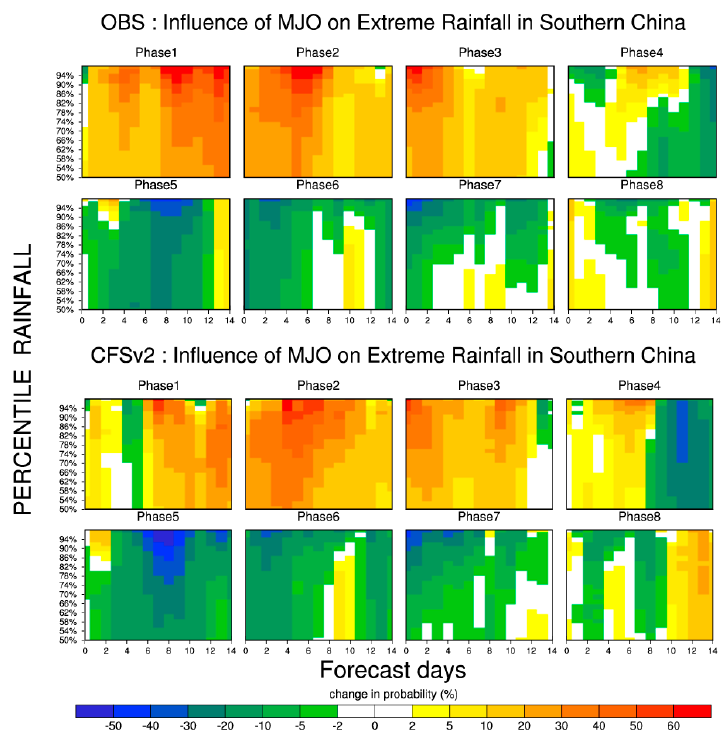
Figure 9. Percentage changes in the probability of rainfall as a function of forecast time (day) in southern China when initialized from phases 1–8 of MJO with respect to a climatological PDF, where the upper two rows represent observations and the bottom two rows for CFSv2.